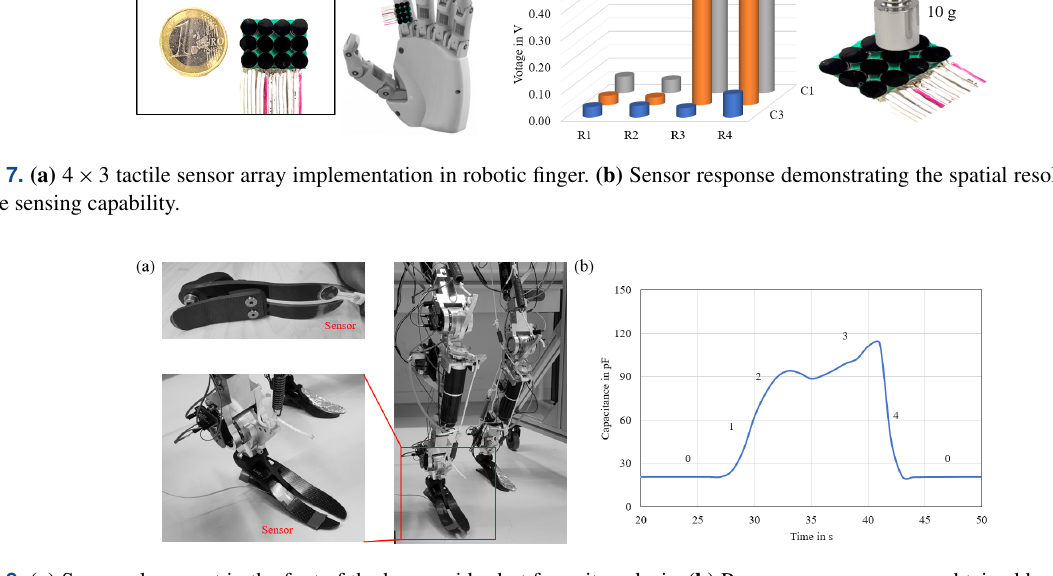
Figure 8. (a) Sensor placement in the foot of the humanoid robot for gait analysis. (b) Pressure response curve obtained by one walk cycle of the